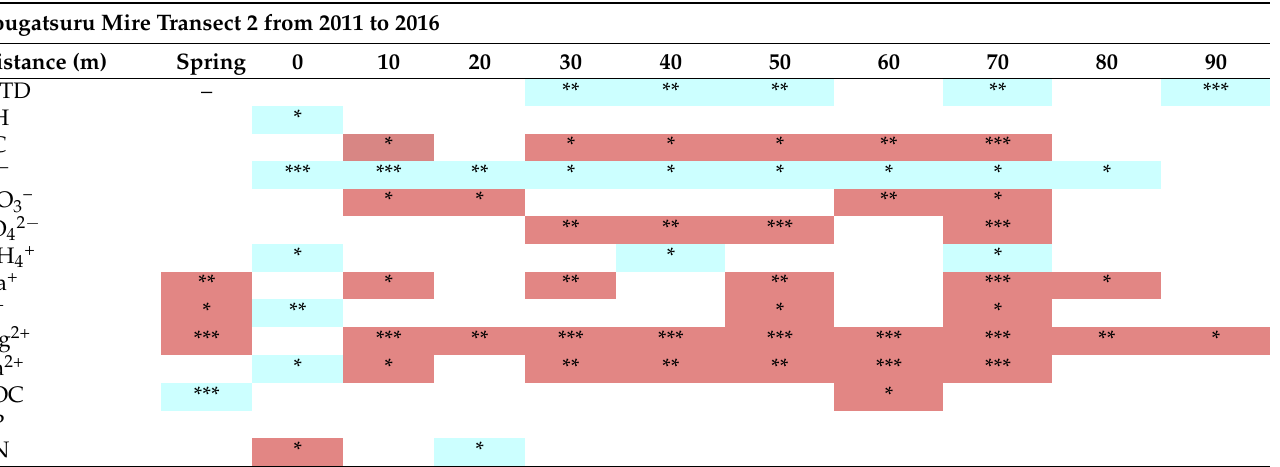
Table 6. Significance levels of regression of water environmental variables and elapsed days in Bougatsuru transect 2 (BGT transect 2) from 2011 to 2016. Red-colored cells mean significant positive slopes and blue-colored cells mean significant negative slopes.